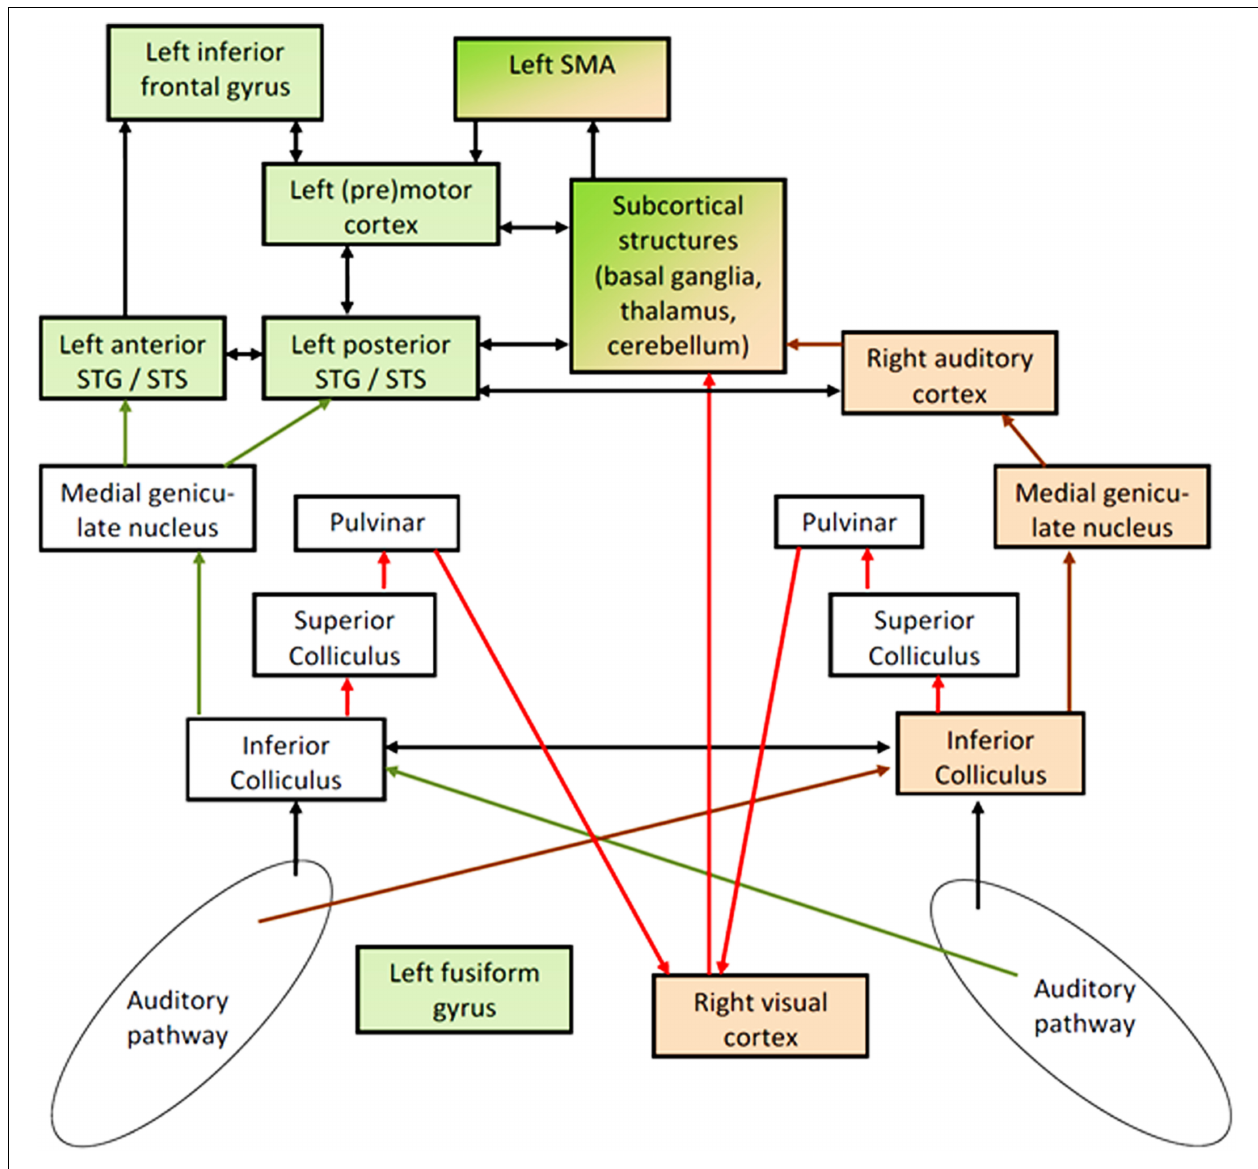
subjects seem to be able to recruit part of their visual cortex – presumably via subcortical afferent auditory information (red arrows) – to represent this prosodic information and to transfer it as an event-trigger channel to the frontal part of the speech processing network. Arrows to and from left FG were omitted in order to avoid an overload of the model and since the major aspect addressed here is the interplay between the right-dominant prosodic and the left-dominant phonological network. Furthermore, direct pathways between visual and auditory cortex were also omitted since the “bottleneck” for understanding ultra-fast speech seems to be located in the interface between sensory processing and frontal speech generation